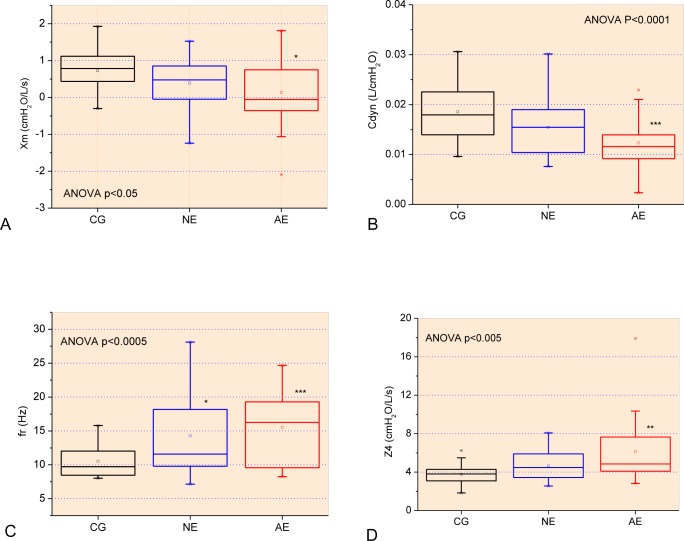
Comparative analysis of the reactive parameters obtained from the control group and patients with normal (NE) and abnormal (AE) spirometry: mean respiratory reactance (Xm; Fig A), resonant frequency (fr, Fig B), dynamic compliance (Cdyn; Fig C) and respiratory impedance module in 4Hz (Z4; Fig D). *p<0.05 related to control group; **p<0.01 related to control group; ***p<0.001 related to control group.